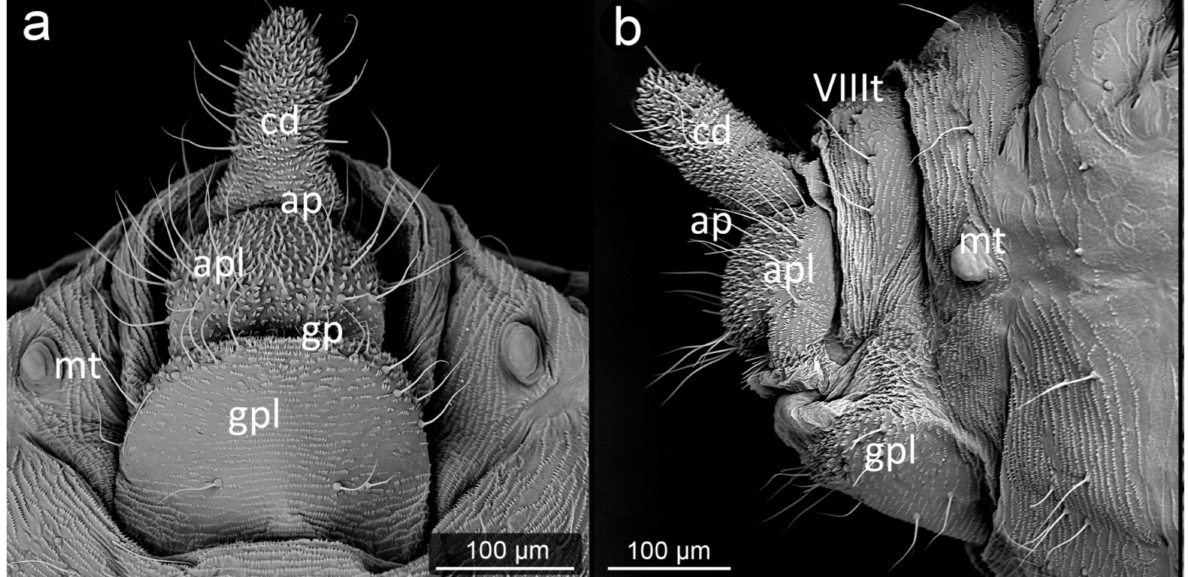
Figure 1. Scanning electron micrographs (SEM) of Aphis fabae showing the general morphology of aphid abdominal and perianal structures: ( a )—ventral view, ( b )—lateral view (t—tergite, cd— cauda, apl—anal plate, gpl—genital plate, mt—marginal tubercle, ap—anal pore, gp—genital pore, VIIIt—abdominal tergite